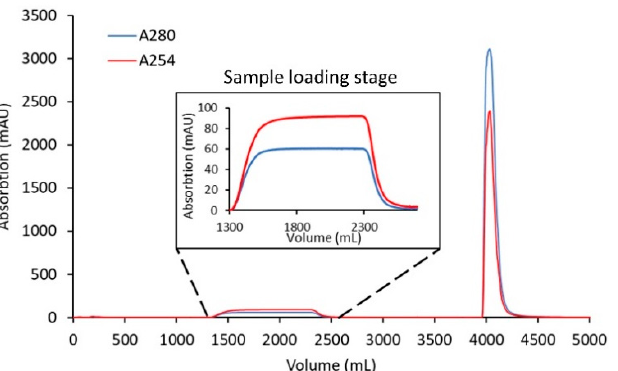
Figure 5. Scale-up clearance of linker-PBD from crude conjugation reaction mixture using the Sartobind ® S membrane. A total of 1.7 g of cys-mAb-PBD crude reaction mixture was loaded onto a 75 mL, 8 mm bed height Sartobind ® S membrane device at a flowrate of 1 MV/min. After loading the sample, the membrane was washed with 20 mM MES buffer at pH 6.0, and then the cys-mAb-PBD conjugate was eluted with 20 mM MES, 350 mM NaCl buffer, pH 6.0. The red line indicates the absorption at 254 nm; the blue line indicates the absorption at 280 nm.